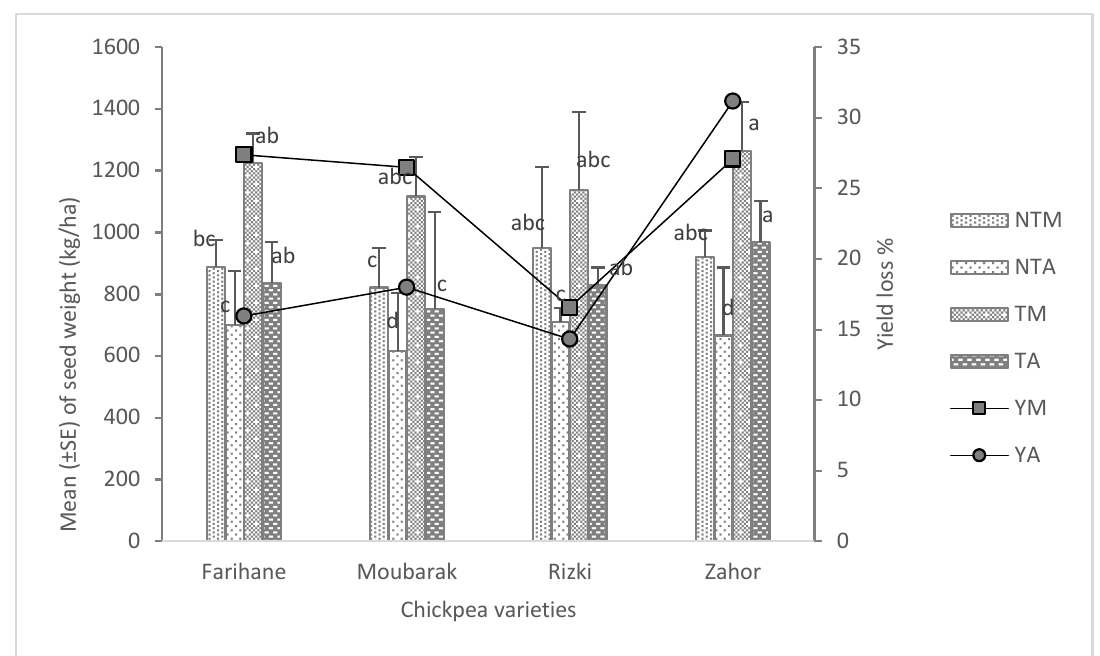
Figure 2. Effect of chickpea pod borer H. armigera infestation on seed weight and yield loss on different varieties at Marchouch and Allal Tazi stations during the cropping season of 2017. NTM: non-treated variety at Marchouch station; NTA: non-treated variety at Allal Tazi station; TM: treated variety at Marchouch station; TA: treated variety at Allal Tazi station; YM: yield loss at Marchouch station; YA: yield loss at Allal Tazi station; means followed by the same letter(s) do not significantly differ at p < 0.05.